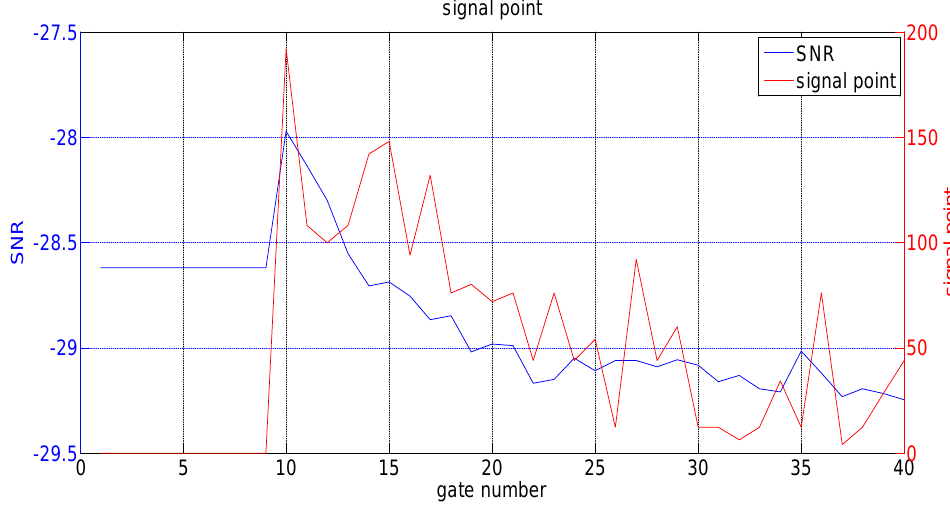
Figure 9. Signal point area at different gates after CR-CFAR.